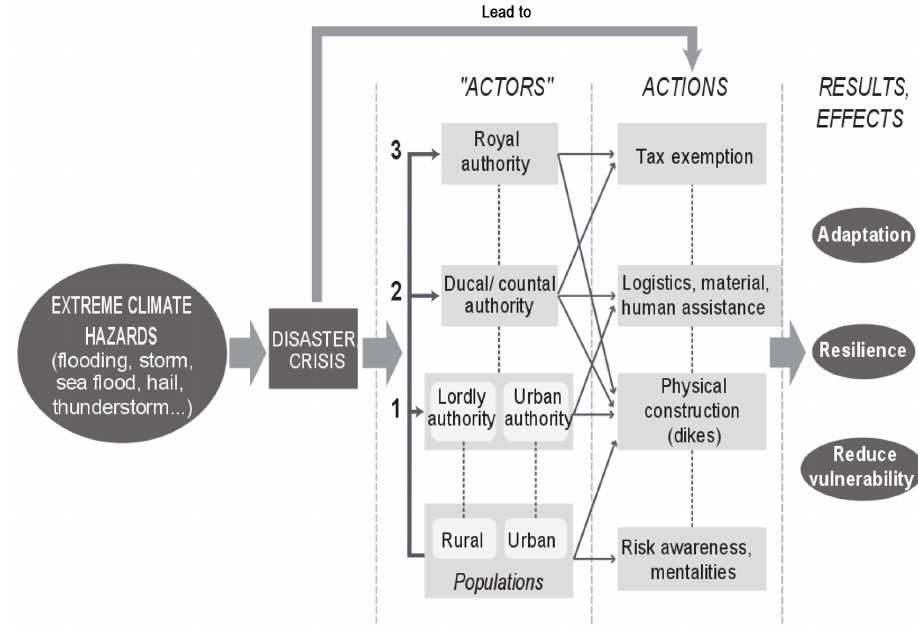
Figure 5. Simplified representation of governance and disaster